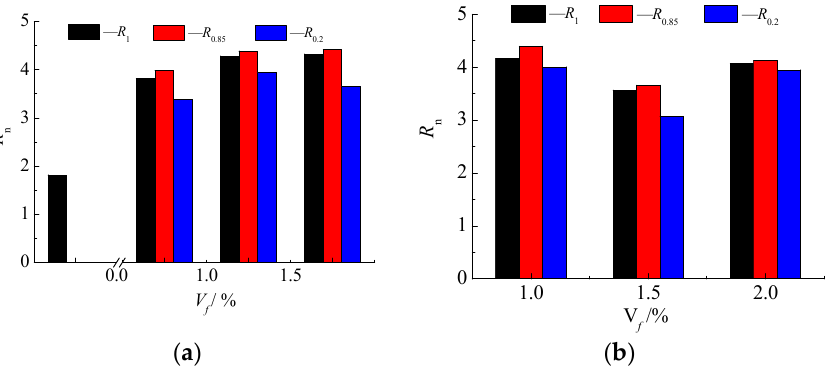
Figure 13. Effect of fiber content on R n : ( a ) 56 d; ( b ) 28 d.